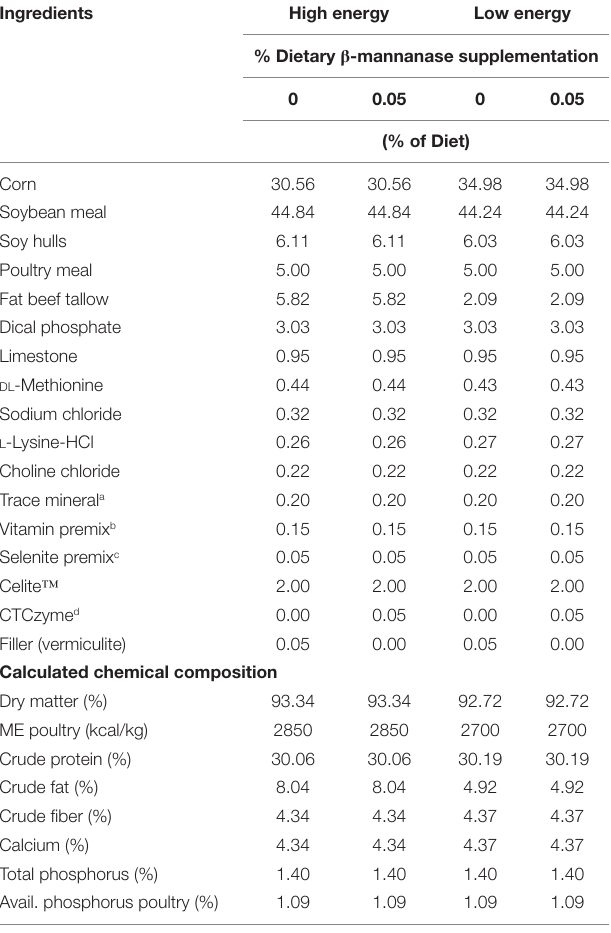
TaBle 1 | Dietary ingredient composition and nutrient composition of starter diets fed to turkey hens from 1 to 28 days of age.